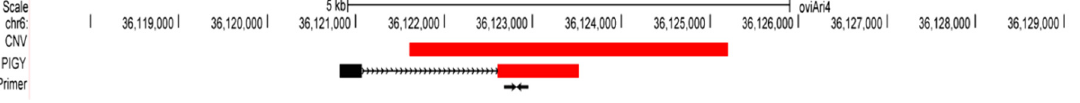
Figure 2. The region of the PIGY gene’s copy number variation (CNV) in sheep breeds. The CNV